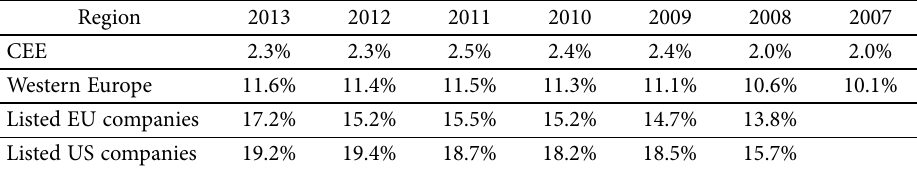
Table 1. Average intangibles in % of total assets